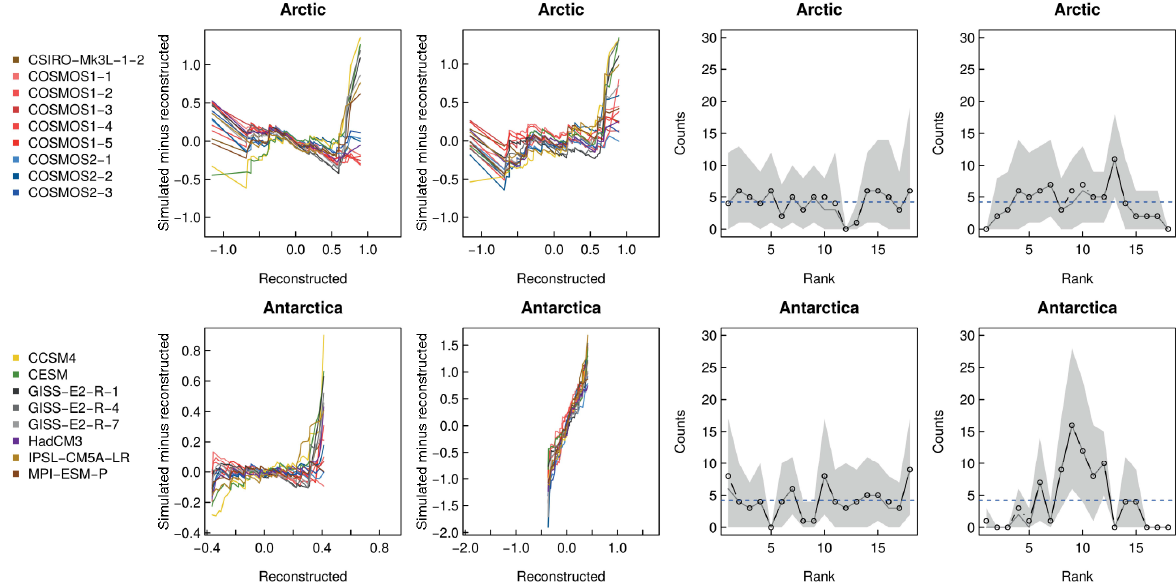
Figure 3. Climatological consistency (first two columns): residual quantile–quantile plots for the full period; probabilistic consistency (last two columns): rank counts for the full period. The top row is for the Arctic, and the bottom row is for Antarctica. For both the climatological and probabilistic consistency, the computations are obtained by neglecting the uncertainties (left plot) and using the uncertainties provided with the original reconstructions (right plot). For the climatological assessment, positive and negative slopes or large differences from 0 emphasize lack of consistency. For the probabilistic measure, U- or dome-shaped features highlight lack of